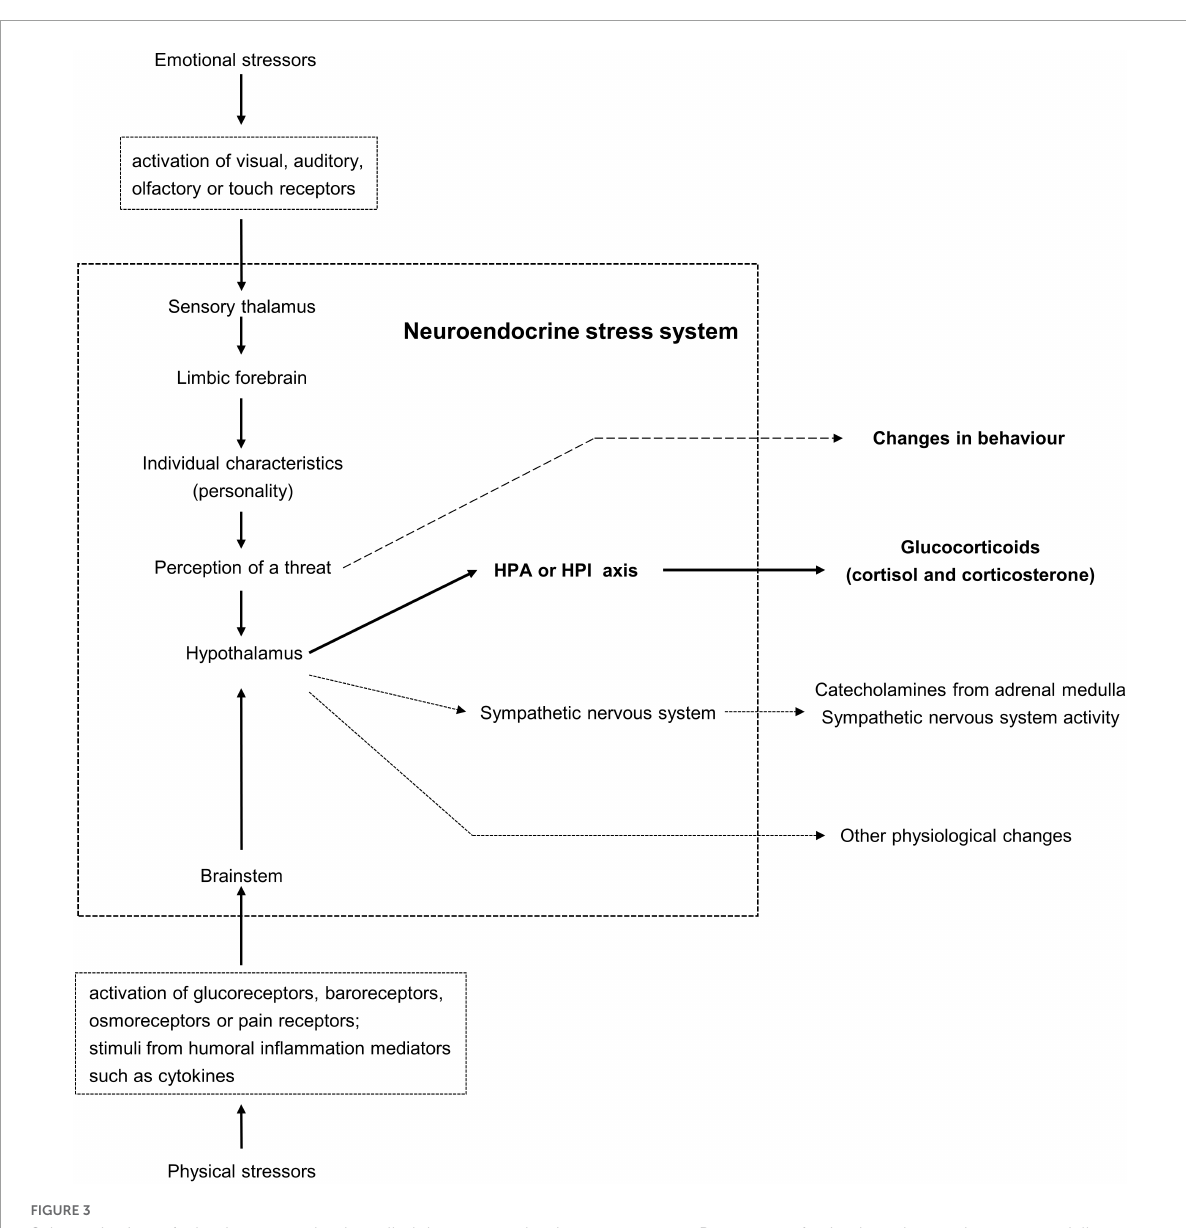
FIGURE3 Schematic view of what is proposed to be called the neuroendocrine stress system. Responses of animals to threatening or potentially threatening changes in the external and internal environments arise from neural pathways and processes which can be called the neuroendocrine stress system, with stimuli that activate the system known as